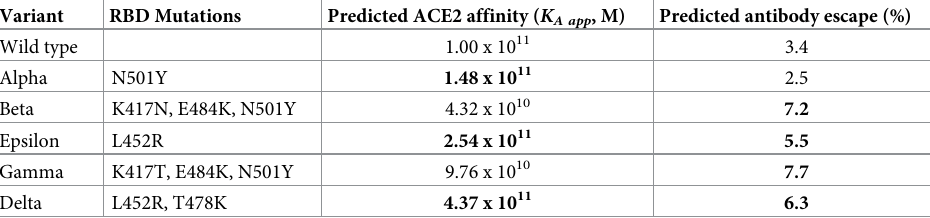
Predictions of increased ACE2 affinity or human serum antibody escape or both relative to wild-type SARS-CoV-2 are indicated by bold values. ACE2 affinities are reported as apparent values because the experimental datasets were obtained using bivalent ACE2 (ACE2-Fc), which results in much higher apparent affinities than those observed for monovalent